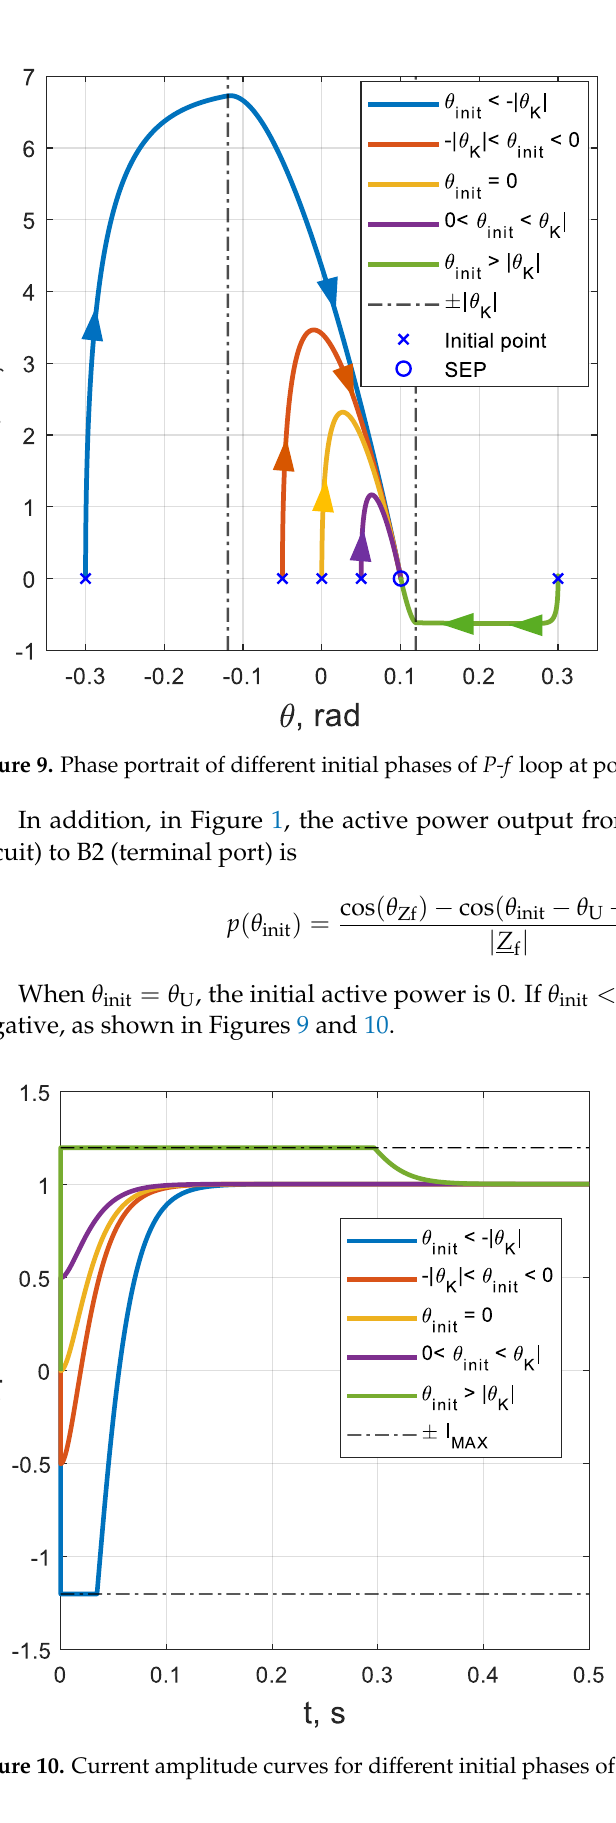
In Figure 10, the three initial points within the threshold range (the three initial points between the two dashed lines in Figure 9) avoid current saturation and allow the active power to settle quickly at a given value. The initial point of the green curve locates outside of the threshold range in Figure 9, so its current amplitude curve settles at the given value after saturation, as provided in Figure 10. The initial point of the blue curve is less than 0 and also locates outside of the threshold range in Figure 9. Thus, its current amplitude curve reaches a negative maxi- mum value before returning to the given value. For power generation converters, outputting negative active power can have a nega- tive impact on the power balance of its DC link [36]. Excessive active power raises the DC link voltage and causes the DC link to cross the safety limit. During the fault, the DC link voltage is protected by the chopper circuit and stays near the voltage threshold. A further influx of energy into the DC link from the grid side will prevent the chopper circuit from continuing to absorb energy. This can lead to the DC link voltage crossing its safety limit, causing the converter to trip or even be damaged. In addition, the active power drawn from the grid by the generation equipment can have a serious negative impact on the stable operation of the grid. Therefore, when restarting the P-f loop during the post-fault period, it is necessary to keep the initial phase close to 𝜃 U , in order to reduce the impact of the initial current on the P-f loop, the converter, and the grid. 3.3. Post-Fault Restart Strategy For ease of understanding, descriptions of the phases used in this section are pro- vided in Table 1. Table 1. Description of different phases. Phase